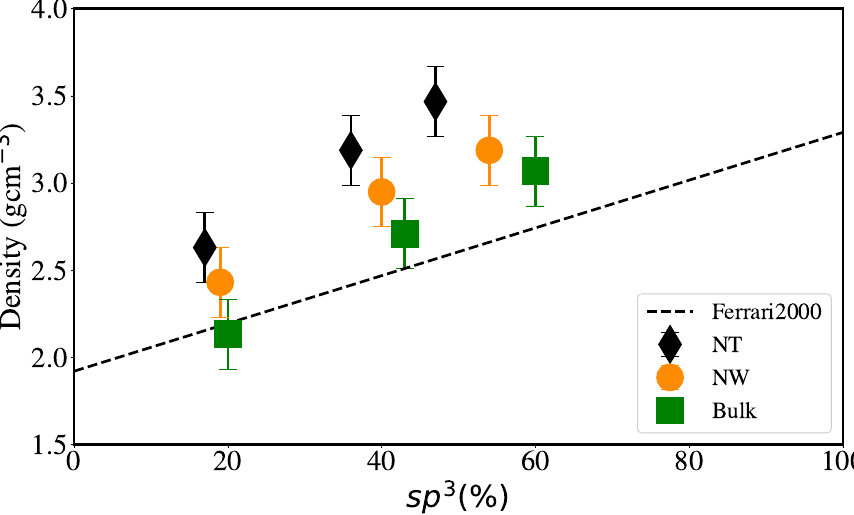
Figure 4. Sample density vs. sp 3 content. The dashed line shows the linear relationship from experiments by Ferrari et al. [32] for aC